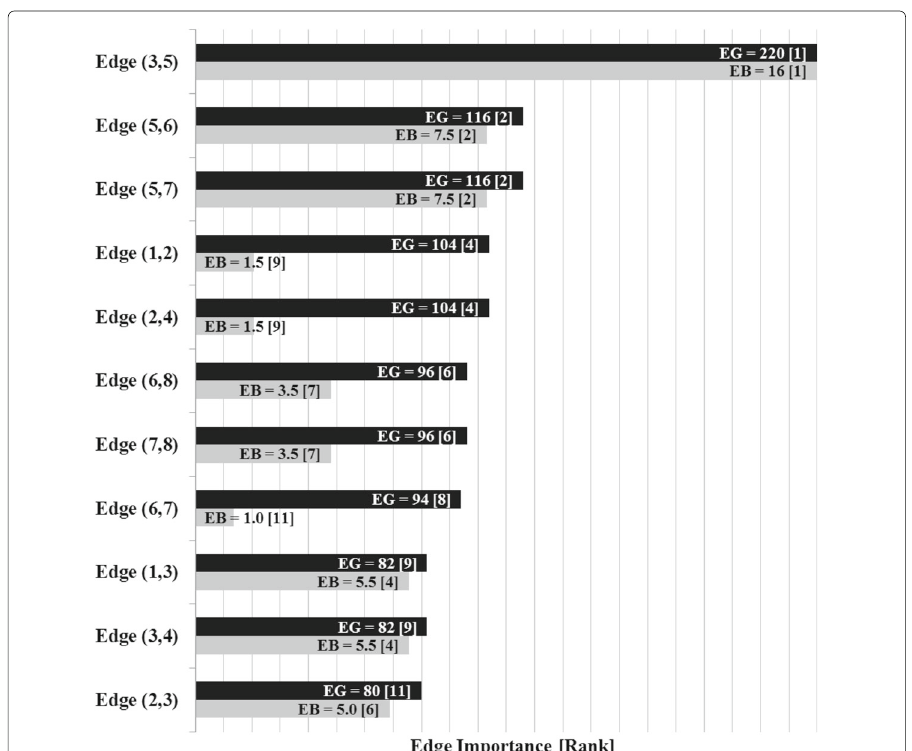
Fig. 5 Edge Gravity (EG) and Edge Betweenness (EB) solutions for the example extension in Fig.